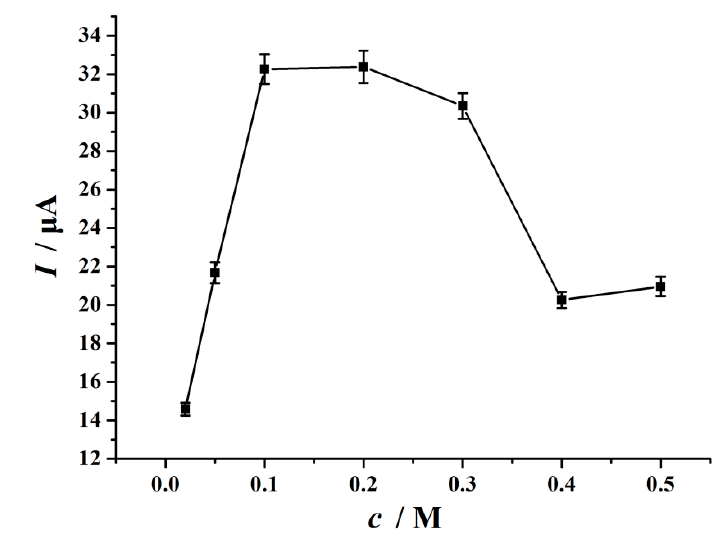
Figure 7. E ff ect of HCl concentration on the peak current of 10 µ M vanillin at CeO 2 / ERGO / Figure 7. Effect of HCl concentration on the peak current of 10 µM vanillin at CeO 2 /ERGO/GCE.